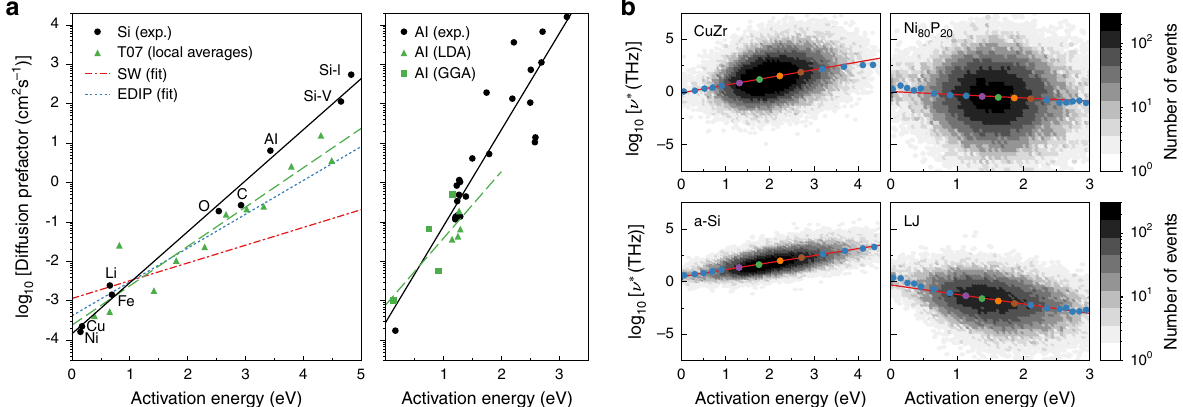
Fig. 1 Compensation in silicon, aluminium, and four amorphous solids. a Compensation effect for diffusion in crystalline silicon (left) and aluminium (right) (experimental and numerical data are all reported in Supplementary Information, the computation of local averages and the fi tting procedure are explained in “ Methods ” ). The compensation factor is equal to 3.0 eV − 1 in silicon, and 5.6 eV − 1 in aluminium. The Stillinger – Weber, EDIP and modi fi ed Tersoff silicon models give compensation factors of 1.0, 2.0, and 2.3 eV − 1 , respectively. Density functional theory data in aluminium — obtained with the local density approximation (LDA) or the generalized gradient approximation (GGA) — also obey compensation, with a compensation factor of 3.8 eV − 1 . b Compensation effect for harmonic activation rates in four amorphous solids: a-Si, CuZr, Ni 80 P 20 , and LJ; compensation factors are extracted from linear fi ts to all data and equal 1.53, 1.68, − 0.70, and − 2.07 eV − 1 , respectively. Dots represent local averages of activation energies and log non-uniform energy bins; their color enables to distinguish transition states investigated in Fig. 2 based on the energy bin they belong